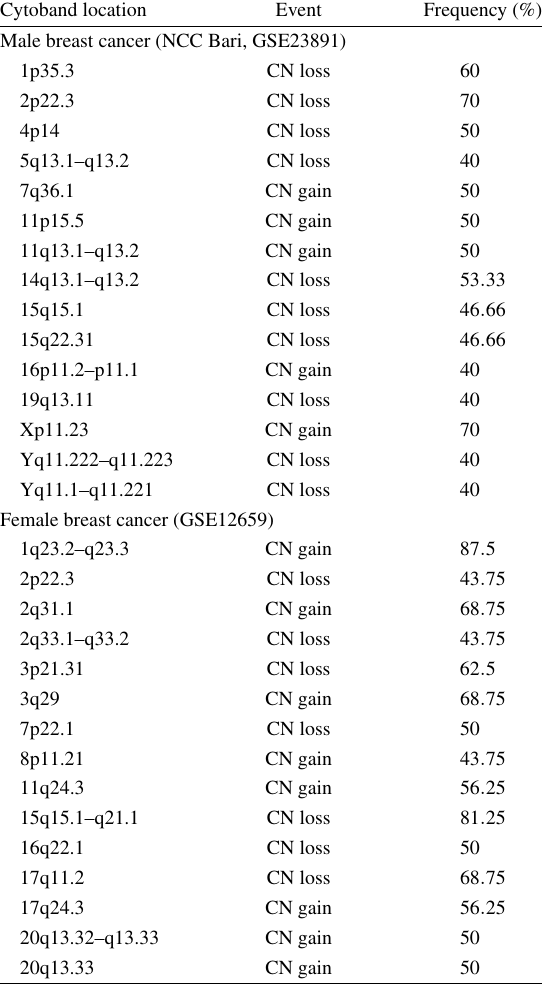
Chromosomal regions more frequently altered in male and female breast cancer Cytoband location